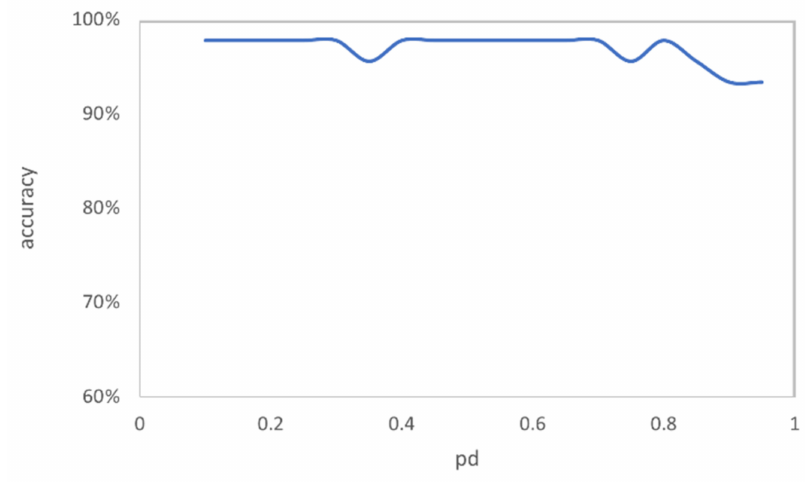
Figure 8. The classification accuracy under different p d values.